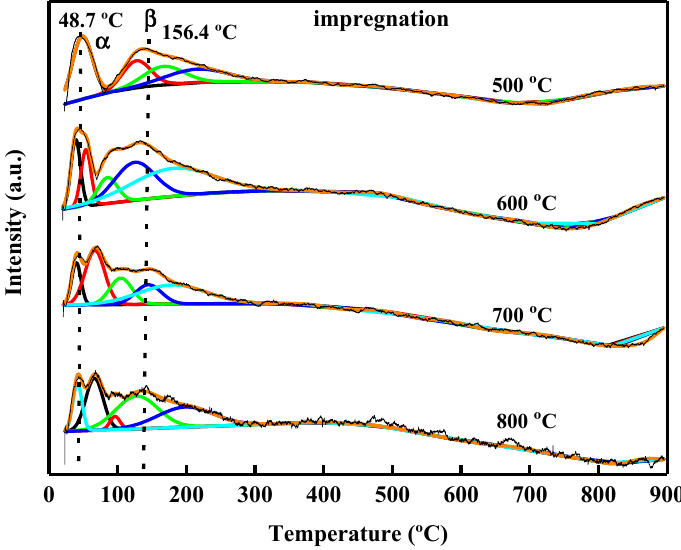
Figure 10. CO 2 -TPD diagram of MgZr-i prepared by impregnation method. Table 4. Base properties of MgO/ZrO 2 catalysts.